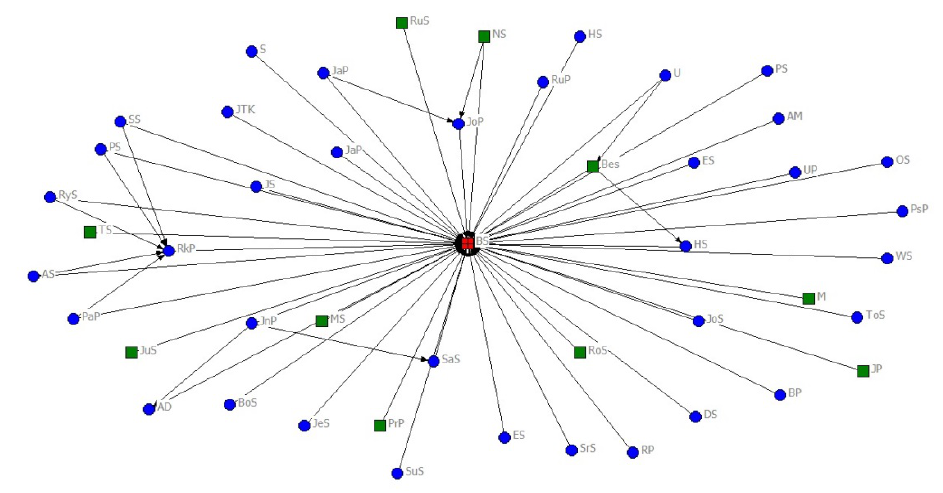
Figure 3: Mapping the BS (Paimaham) Group Social